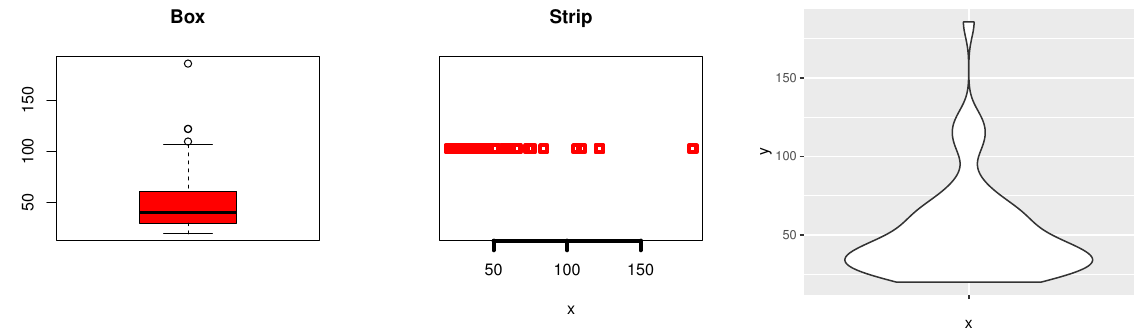
Figure 2. Data description for the flood data using box, strip, and violin plots.